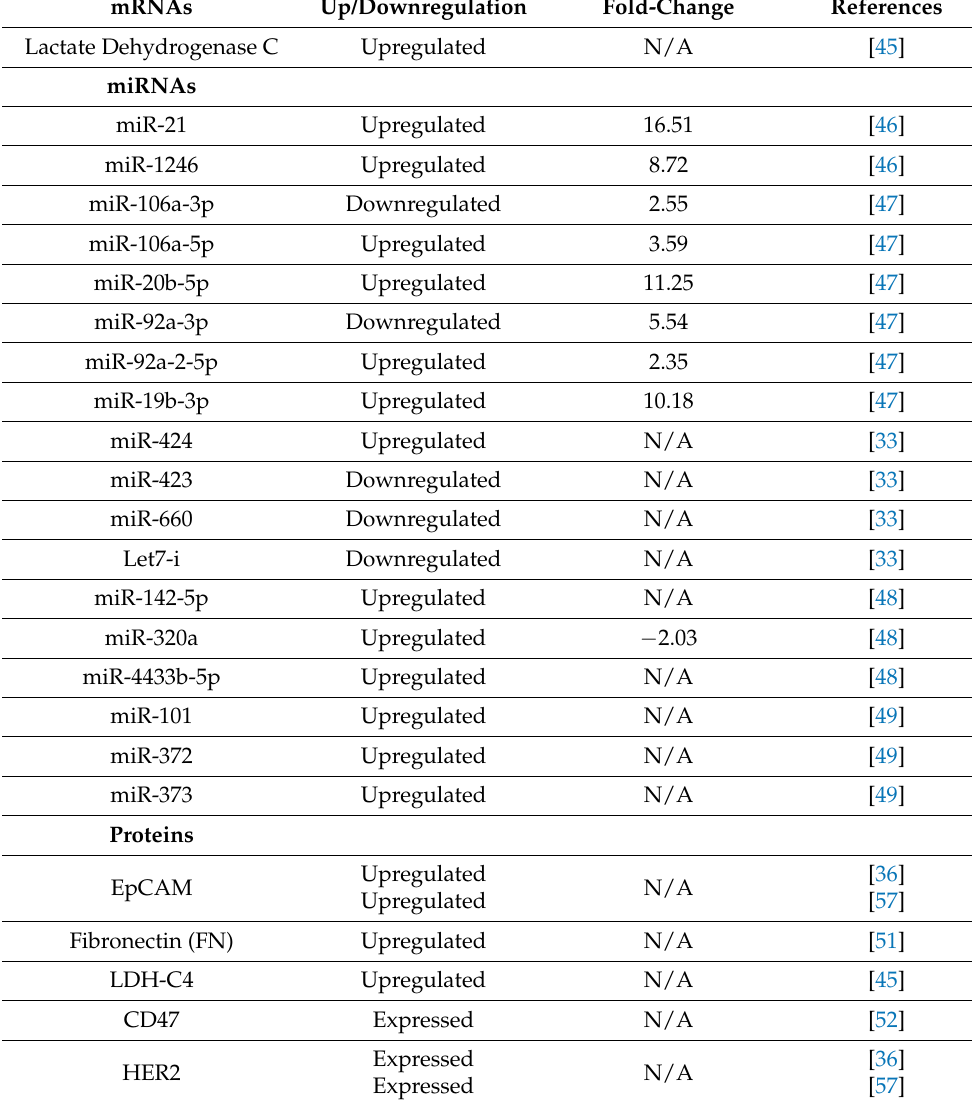
Table 1. EV-associated biomarkers in breast